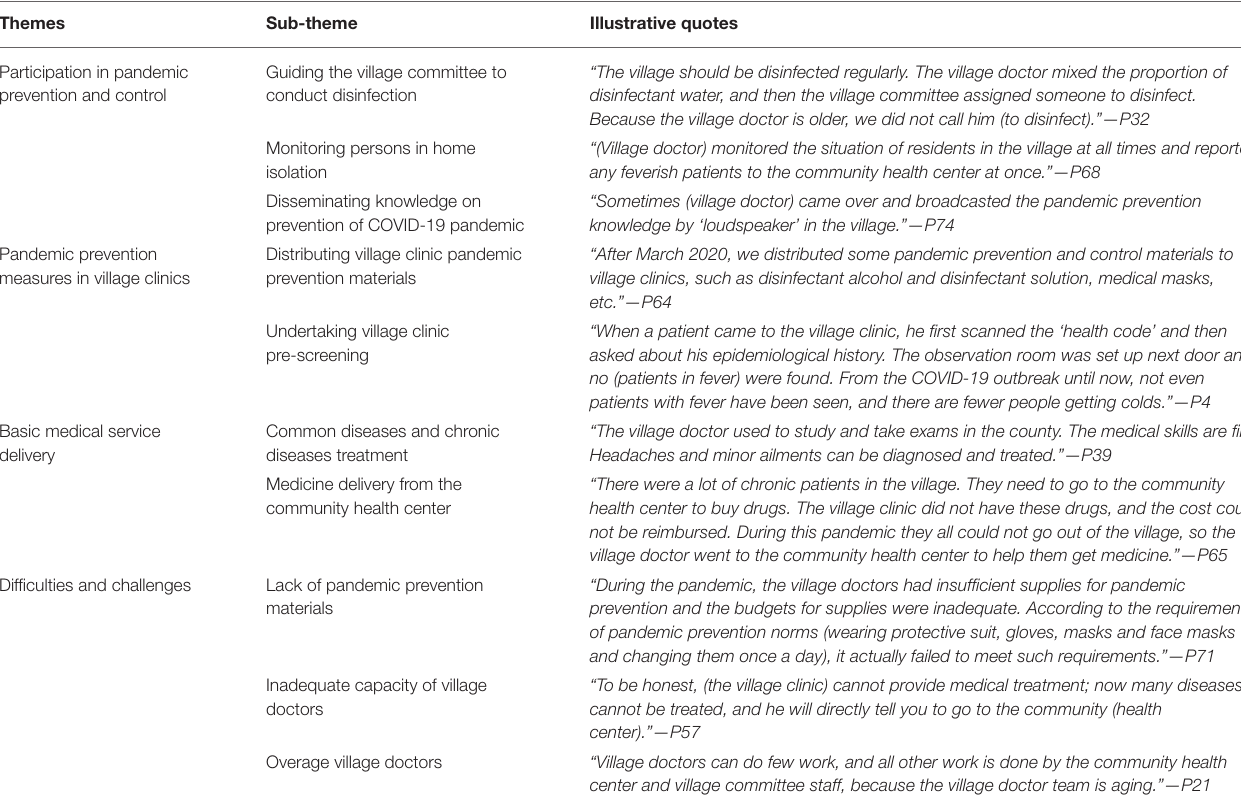
TABLE 3 | Themes for village doctors’ responsibilities and challenges in the COVID-19 pandemic prevention and